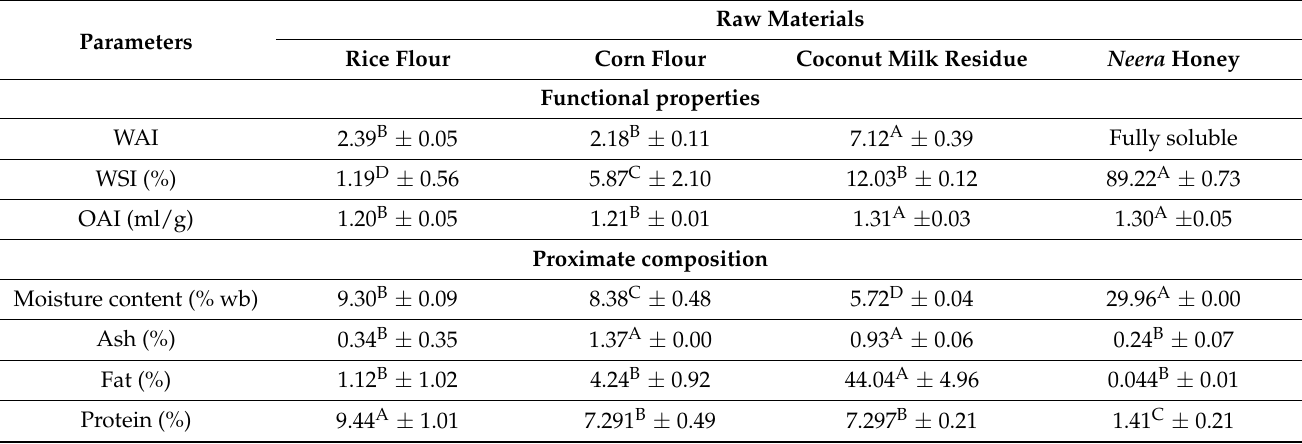
Table 2. Functional properties and proximate composition of raw materials used for preparation of